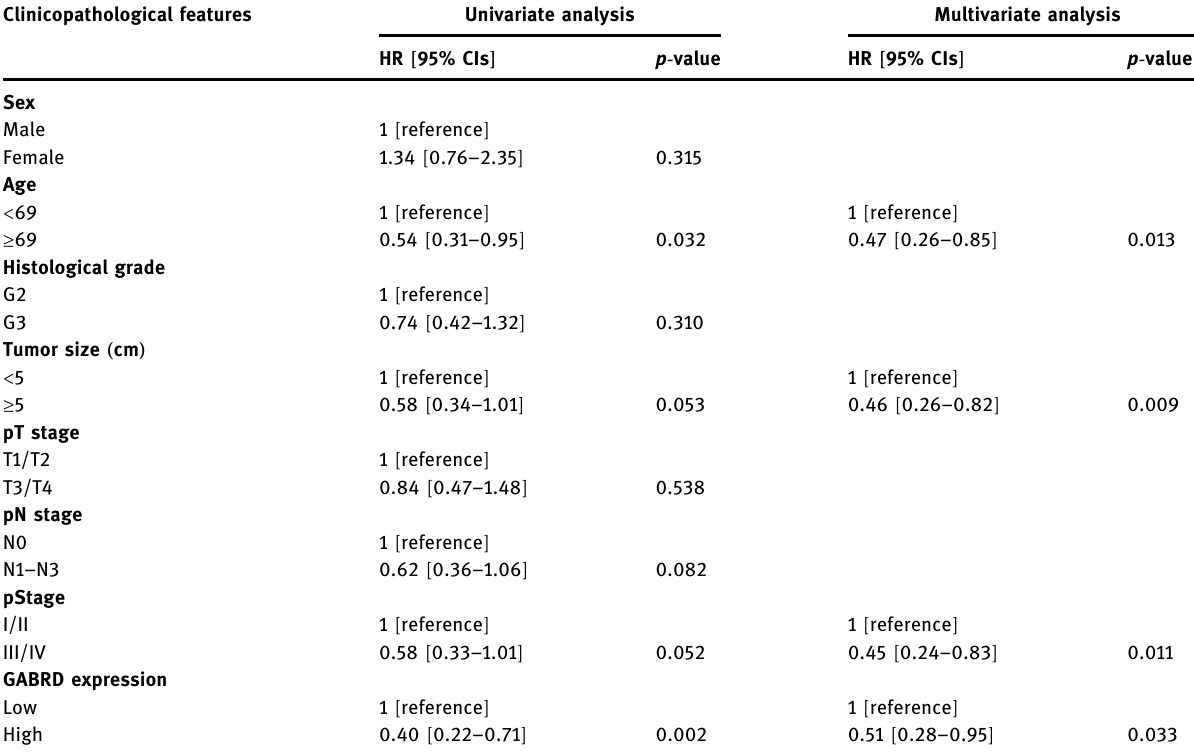
Table 2: Univariate and multivariate models for overall survival in the TMA cohort ( n = 100 )